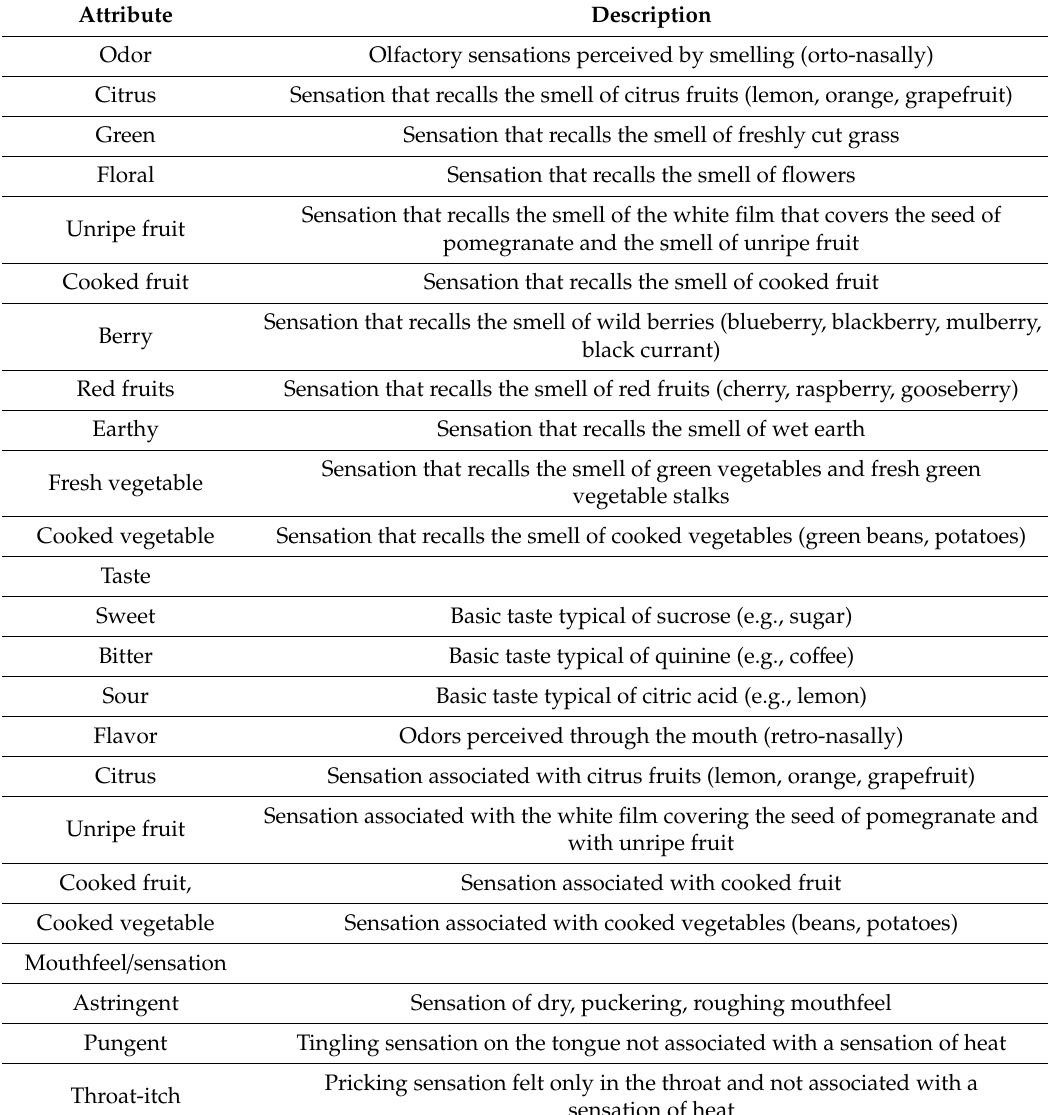
Table 1. Attribute list used for the sensory evaluation of pomegranate juices treated with di ff erent preservation